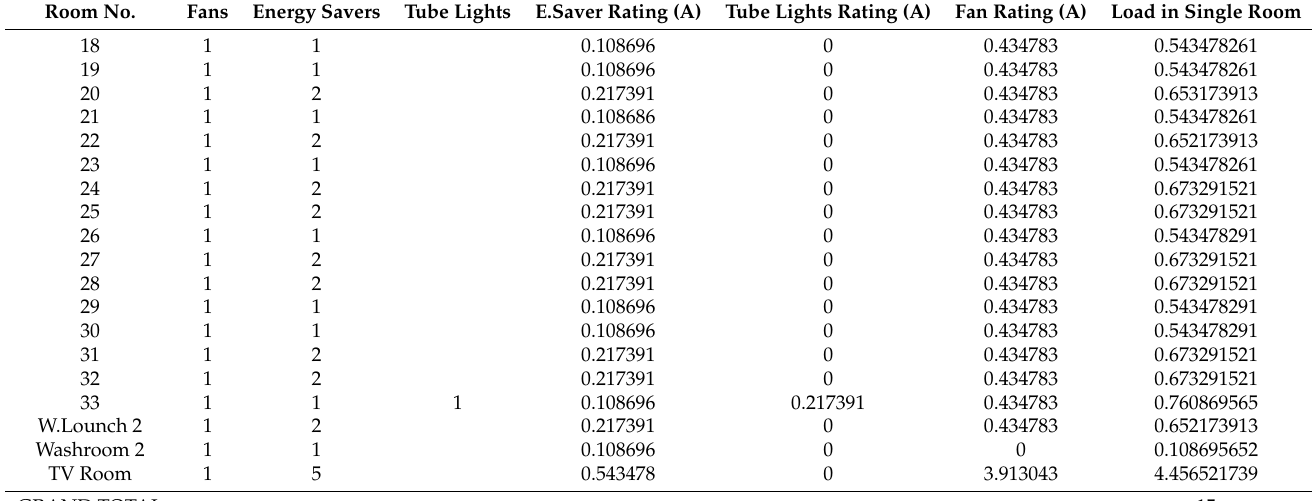
Table 5. Faqir API Hostel (1st floor) existing load data.